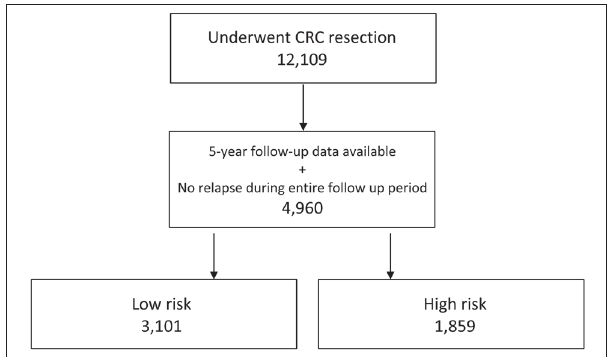
Figure 1) Patient selection. CRC Colorectal cancer